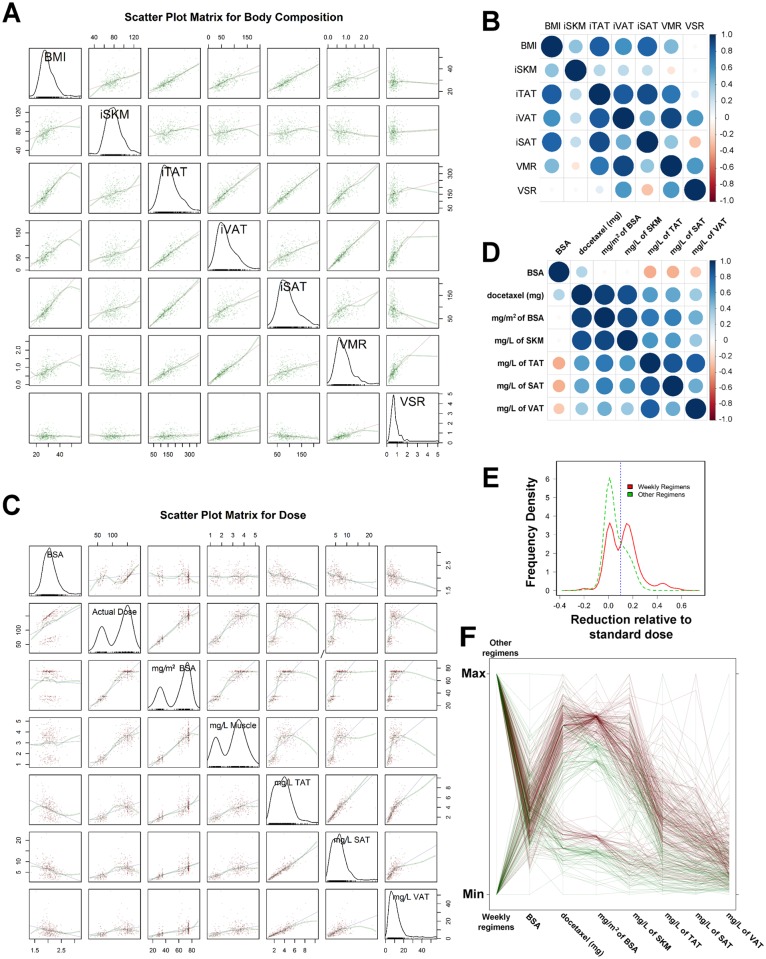
Correlations among body composition parameters and among docetaxel dosage calculations.A) A matrix of scatter plots for body composition parameters is shown. The frequency distribution of each body composition parameter is presented as labeled at the diagonal of the matrix. B) A correlation matrix of the body composition parameters is shown. The sizes of the dots indicate the magnitude of the correlation, and the dots are color coded for the correlation coefficient according to the scale on the right. The correlation coefficients are reported in the corresponding boxes reflected across the diagonal. C) A matrix of scatter plots for dosages calculated based on body composition parameters is shown. The frequency distribution of each parameter is presented as labeled at the diagonal of the matrix. D) A correlation matrix of the dosages is shown in a manner similar to that for B. E) The probability density function, estimated by kernel density estimation, of the proportion of the initial docetaxel dose relative to the reference dose for the weekly regimens (red solid line) and for the other regimens (green dashed line). The blue vertical dotted line represents a 10% reduction of the initial docetaxel dosage relative to the respective reference dosage for the groups as labeled. F) A parallel coordinates plot is drawn to demonstrate the relationships among covariates such as the type of docetaxel regimen, the dose of docetaxel in milligrams, and docetaxel dosages calculated based on body composition parameters. The patients with empirical reduction of the initial docetaxel dosage based on mg/m2 BSA by ≥10% are represented by green lines, and those otherwise are represented by brown lines.